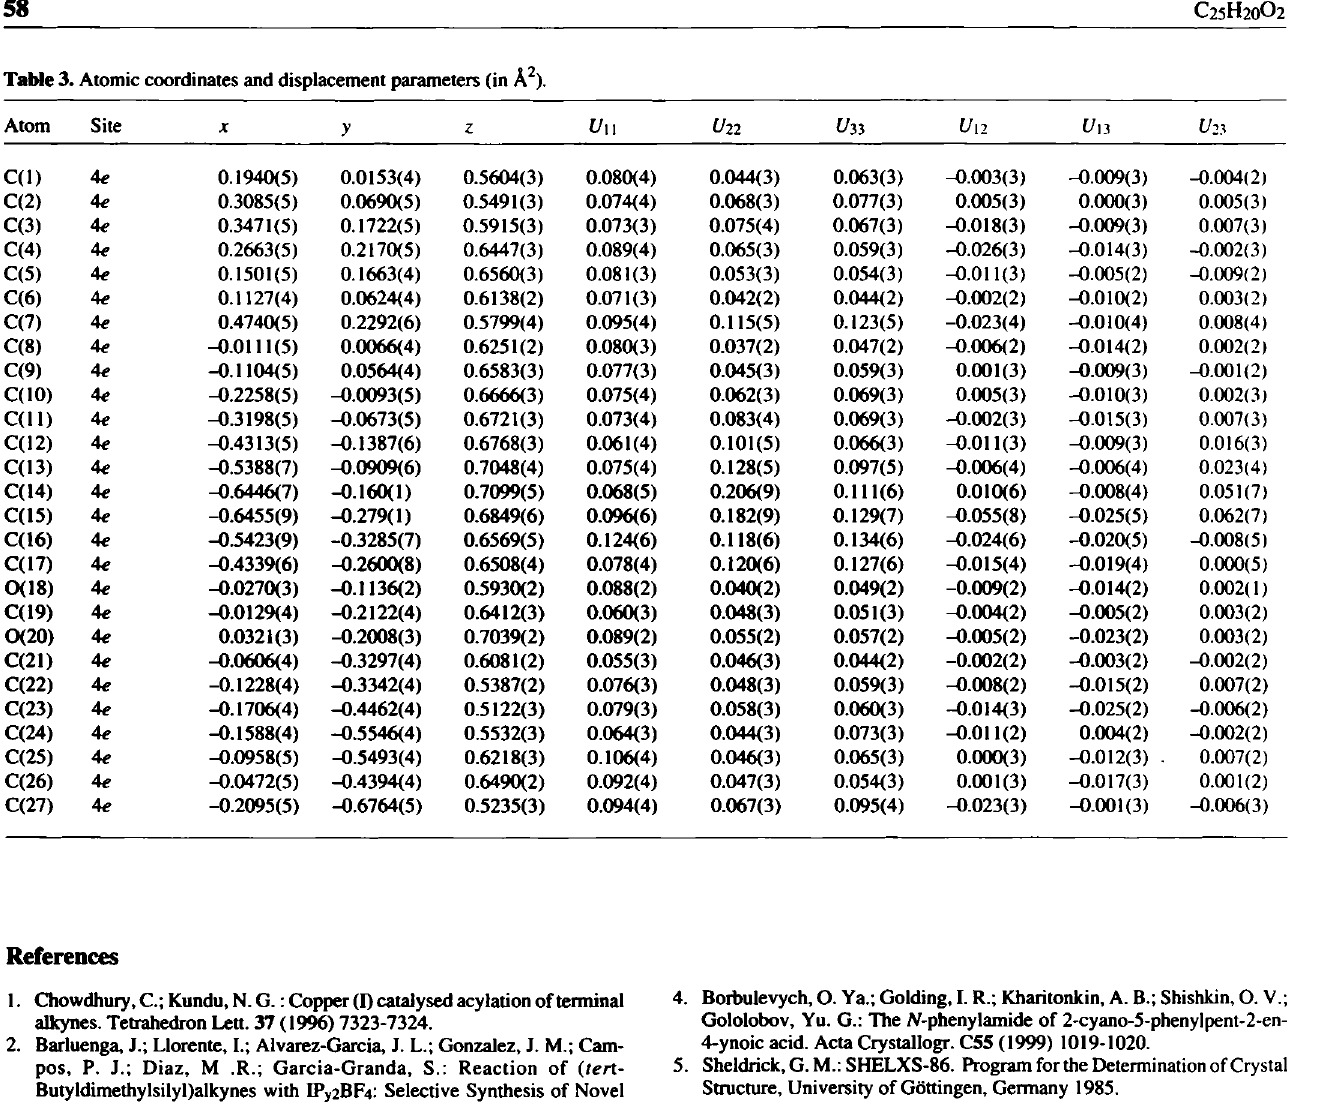
Table 3. Atomic coordinates and displacement parameters (in A 2